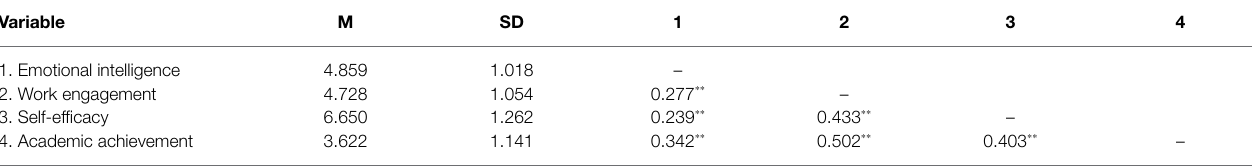
TABLE 1 | Descriptive statistics and correlations (N = 365). Variable